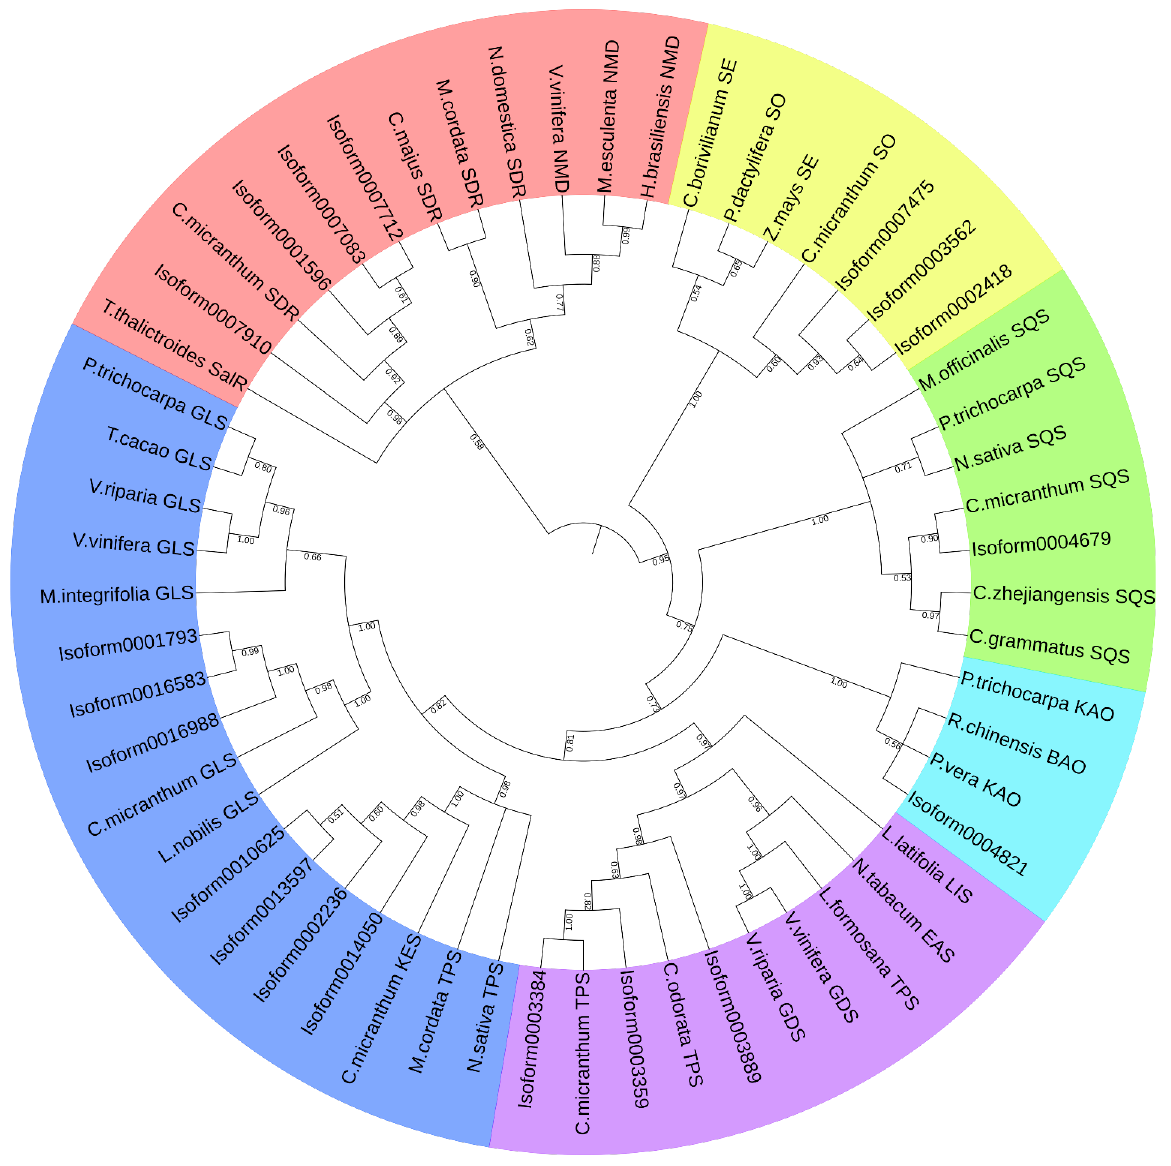
Figure 9. The result of phylogenetic analysis.